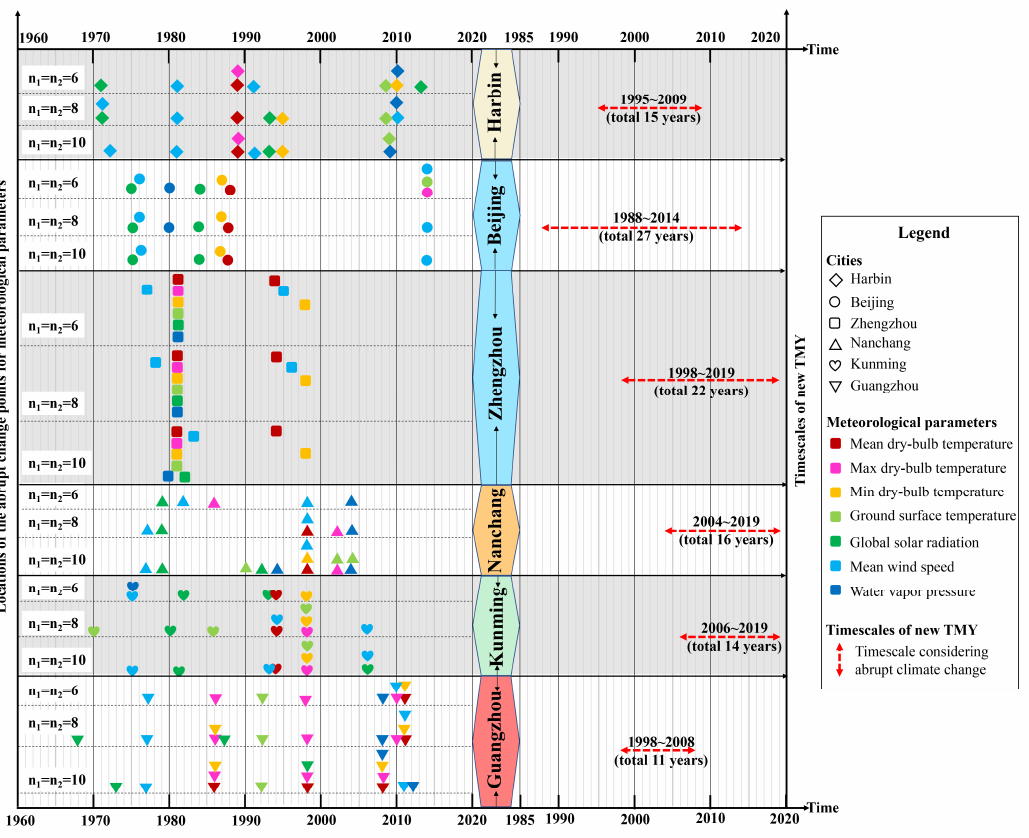
Figure 4. ACC analysis results of all meteorological parameters of a typical meteorological year (TMY).